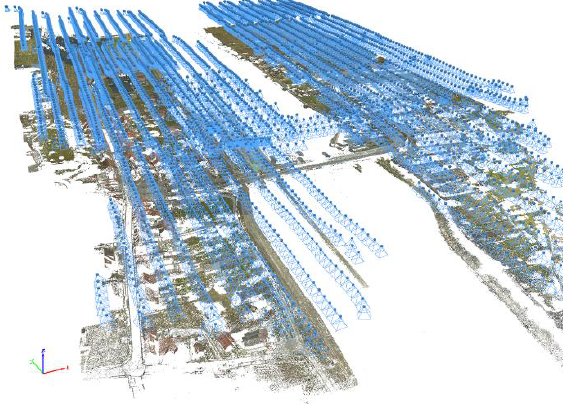
Figure 3. Photogrammetric coverage of the full project site (18 consecutive flight missions, nom. GSD 3.7 mm).